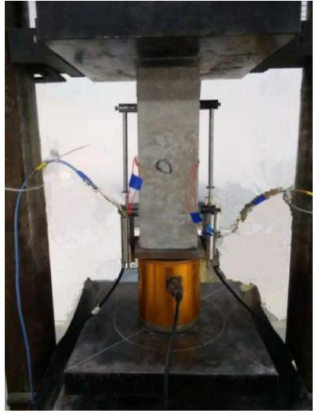
Figure 2. Test setup of loading and